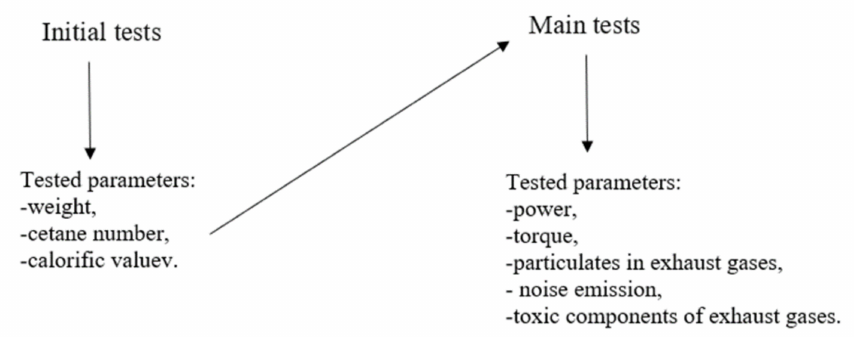
Figure 2. Stages of the